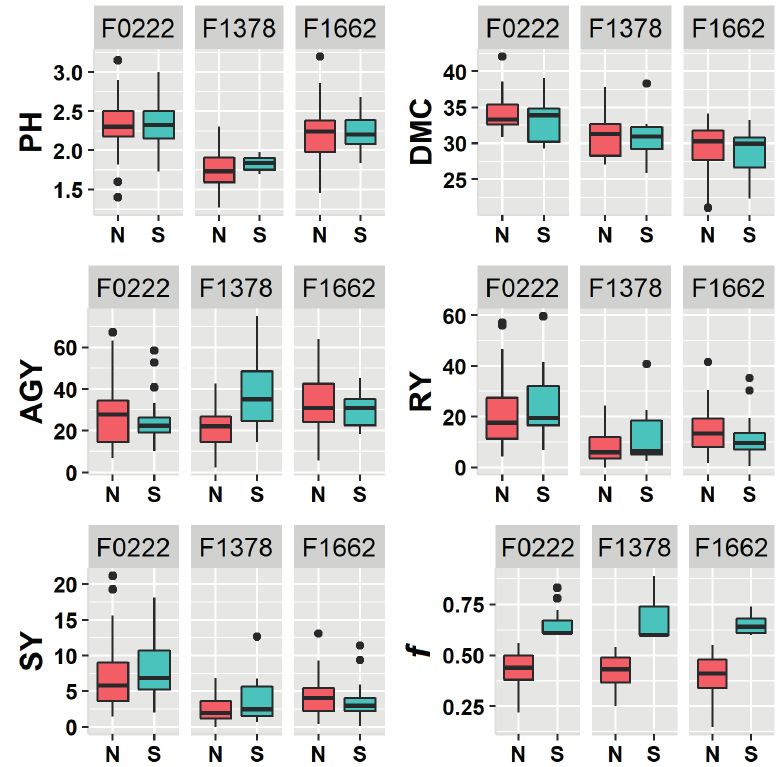
cassava individuals from the self-pollination Figure 5 - Boxplot of the selection of S 1 of the accessions BGM0222 (F0222), BGM1378 (F1378) and BGM1662 (F1662), based on the inbreeding coefficient ( f ). N: group of unselected individuals with f < 0.60. S: group of individuals selected with f ≥ 0.60. PH: plant height (m); DMC: root dry matter content (%); AGY: above ground yield (t.ha -1 ); RY: root yield (t.ha -1 ); SY: starch yield (t.ha -1